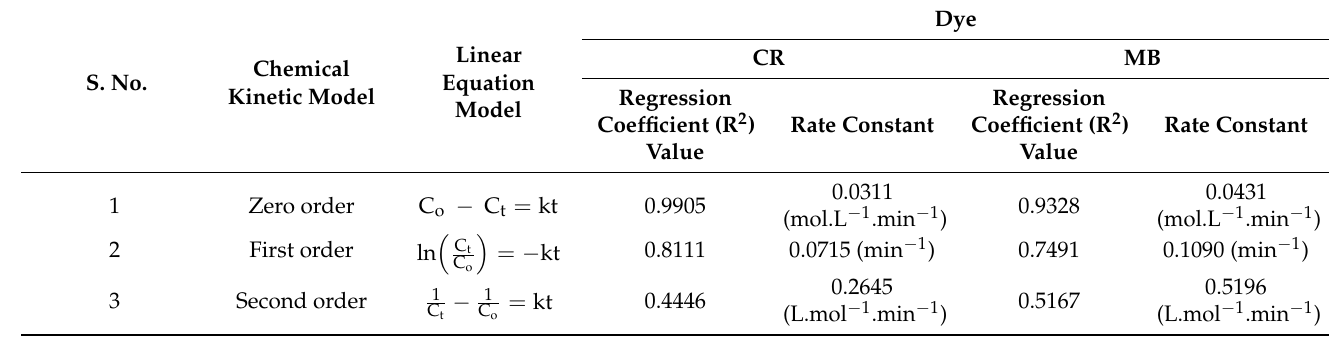
Table 2. Different linear equation models and their respective regression coefficient (R 2 ) values and rate constantsfor CR and MB dye after applying CA-AgNPs (0.05%) and NaBH 4 (5.0 mM).